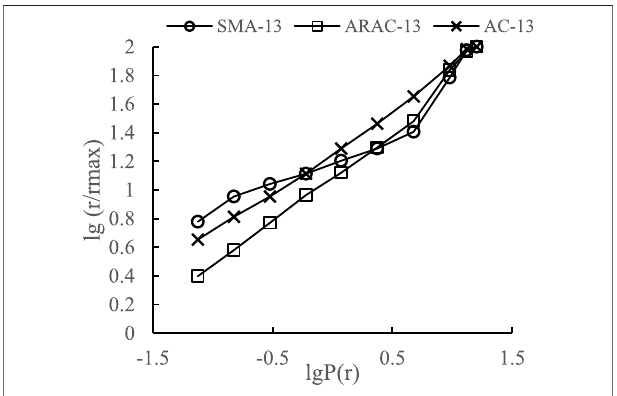
FIGURE 5 | Double logarithmic scatter plot of three gradation curves.